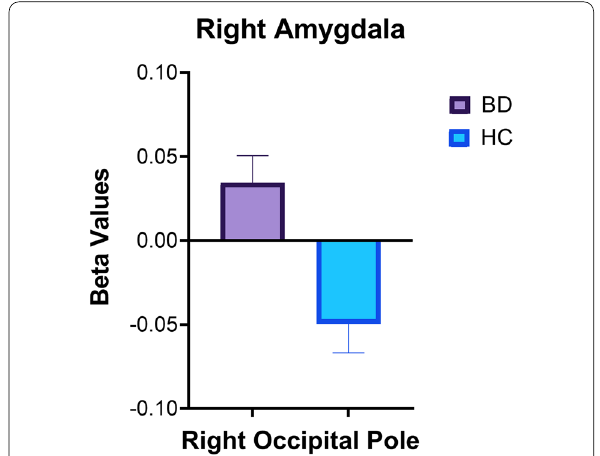
Fig. 1 The main effect of bipolar disorder (BD) diagnosis on rsFC between the right amygdala seed and right occipital pole ( p Beta values correspond to Fischer-transformed correlation coefficient values, adjusted for age, sex, and race. Error bars denote standard error of the mean. HC healthy controls